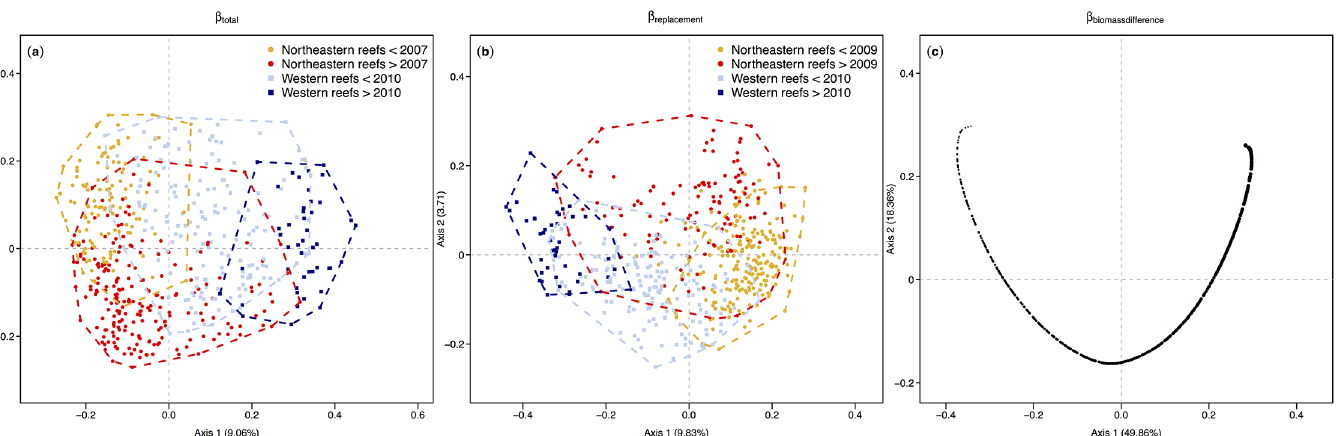
Fig 2. Principal coordinates ordination (PCoA) biplots of beta diversity and its components. (a) PCoA of the square-rooted dissimilarity matrix among all observations. Dissimilarity was measured using the percentage-difference (alias Bray-Curtis) index on square-rooted fish biomass data. (b) PCoA of the dissimilarity matrix accounting only for biomass replacement between pairs of observations ( β replacement ). (c) PCoA on the dissimilarity matrix accounting only for biomass differences between pairs of observations ( β biomasdifference ). Groups identified in ordinations (a) and (b) are the four groups identified using MRT. In ordination (c), observations are ordered along a total square-rooted biomass gradient (see S3 Fig for